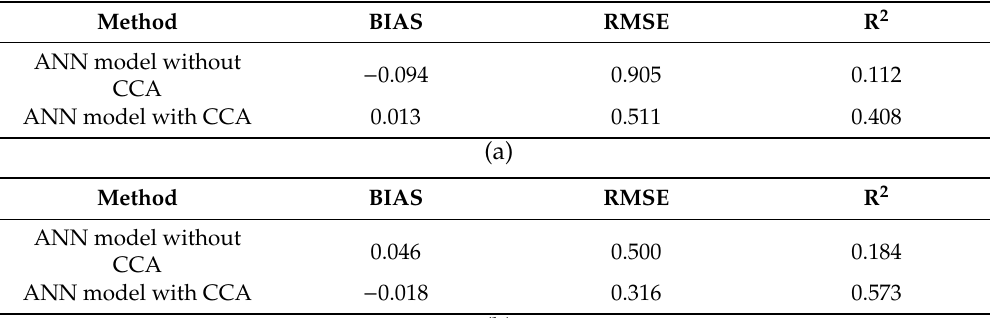
Table 5. Results based on the artificial neural networks (ANN) model without the canonical correlation analysis (CCA) and the ANN model with the CCA for the ( a ) two-year quantile and ( b ) five-year quantile derived from the Gamma distribution.